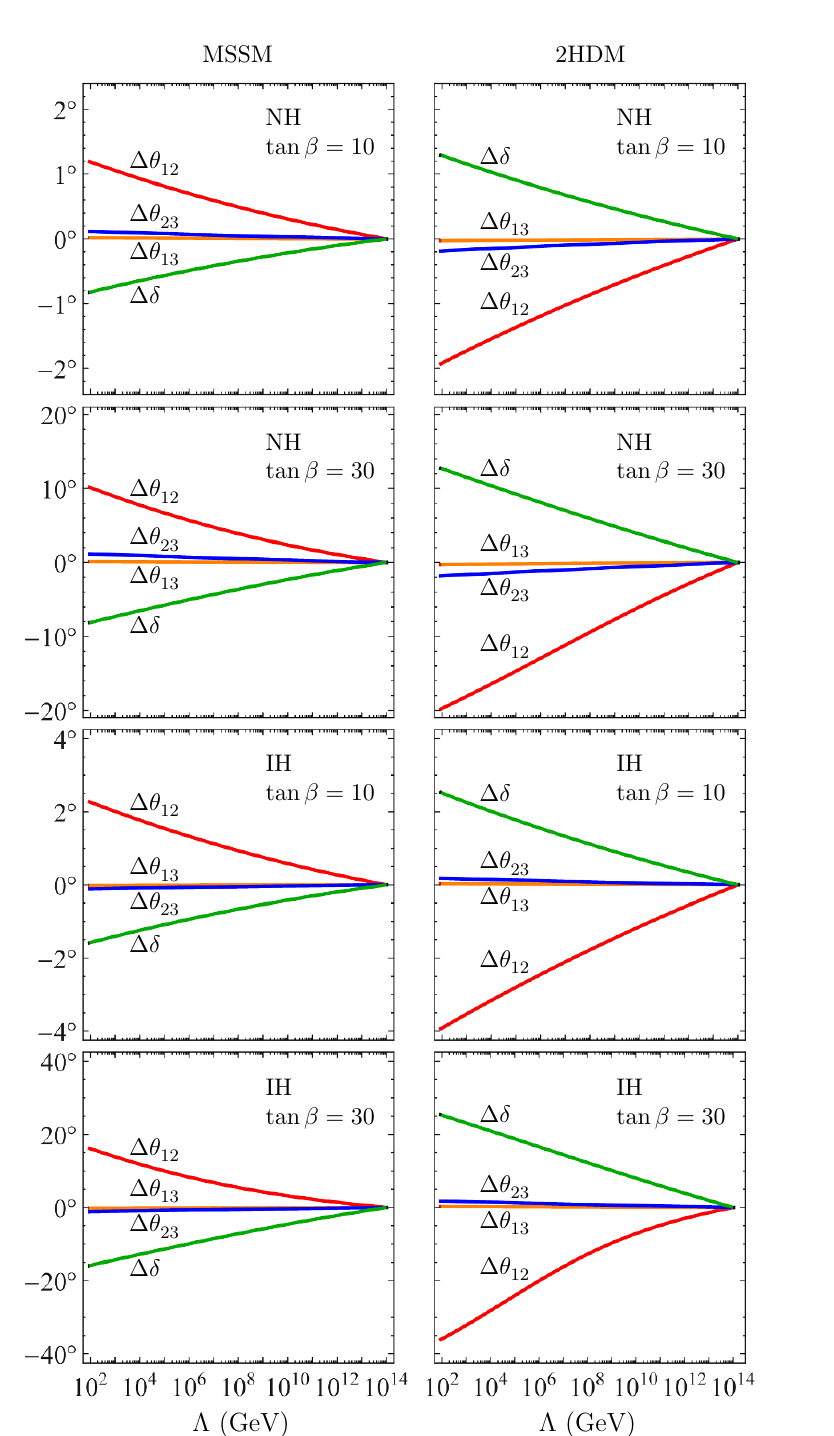
Figure 2 . The changes of ∆ θ , ∆ θ , ∆ θ and ∆ δ with the energy scale Λ in the MSSM and the 12 13 23 type-II 2HDM, where m = 0 . 05 eV at Λ = 10 2 GeV is typically input and θ F lightest δ = 3 π/ 2 at Λ = 10 14 GeV are fixed by the µ - τ reflection µτ